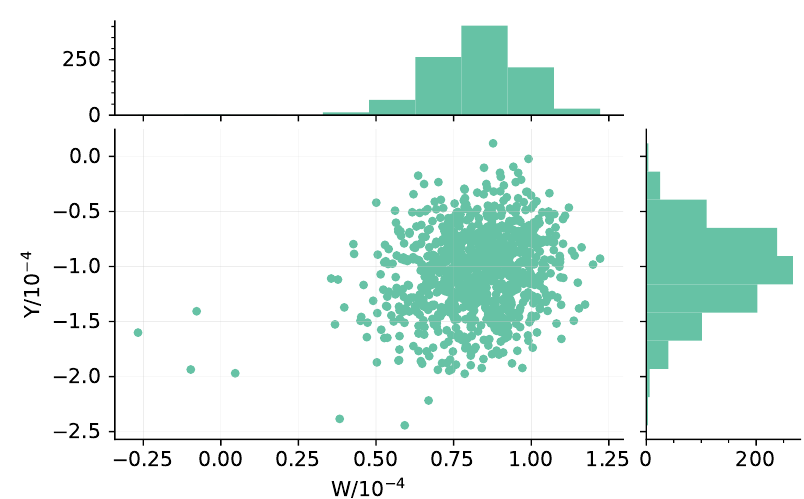
Figure 16 . Distribution of best fit ( W, Y ) parameters for each Monte Carlo replica. The data used for the fit was generated by a pre-selected PDF before the SM predictions were transformed to a SMEFT observable with ( W, Y ) = (1 , − 1) × 10 − 4 . The upper panel is the histogram of best fit values in the W axis while the right panel is the histogram for the Y